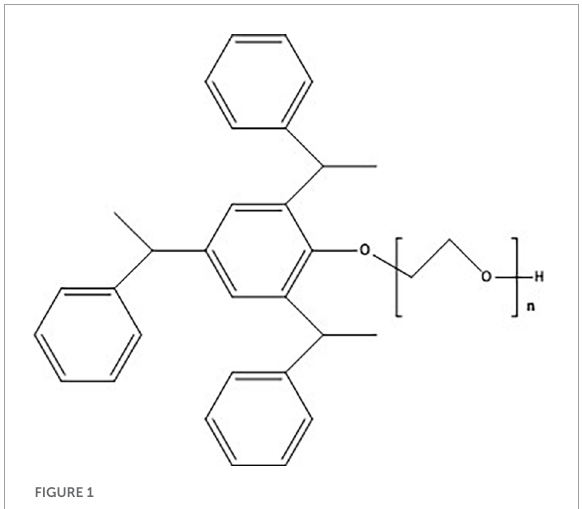
FIGURE1 Chemical structure of tristyrylphenol ethoxylates (TSPEOn) ( n =